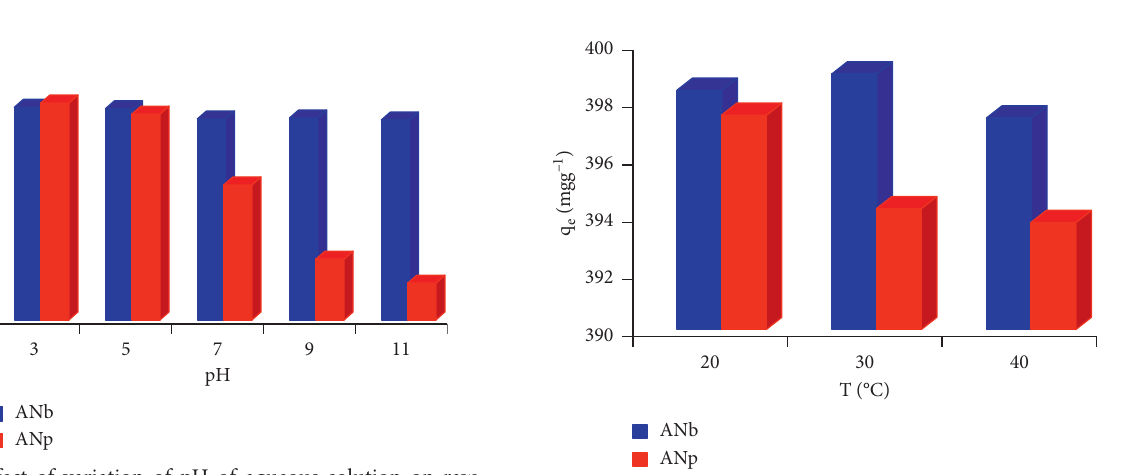
Figure 4: Effect of temperature on raw (ANb) and purified (ANp)